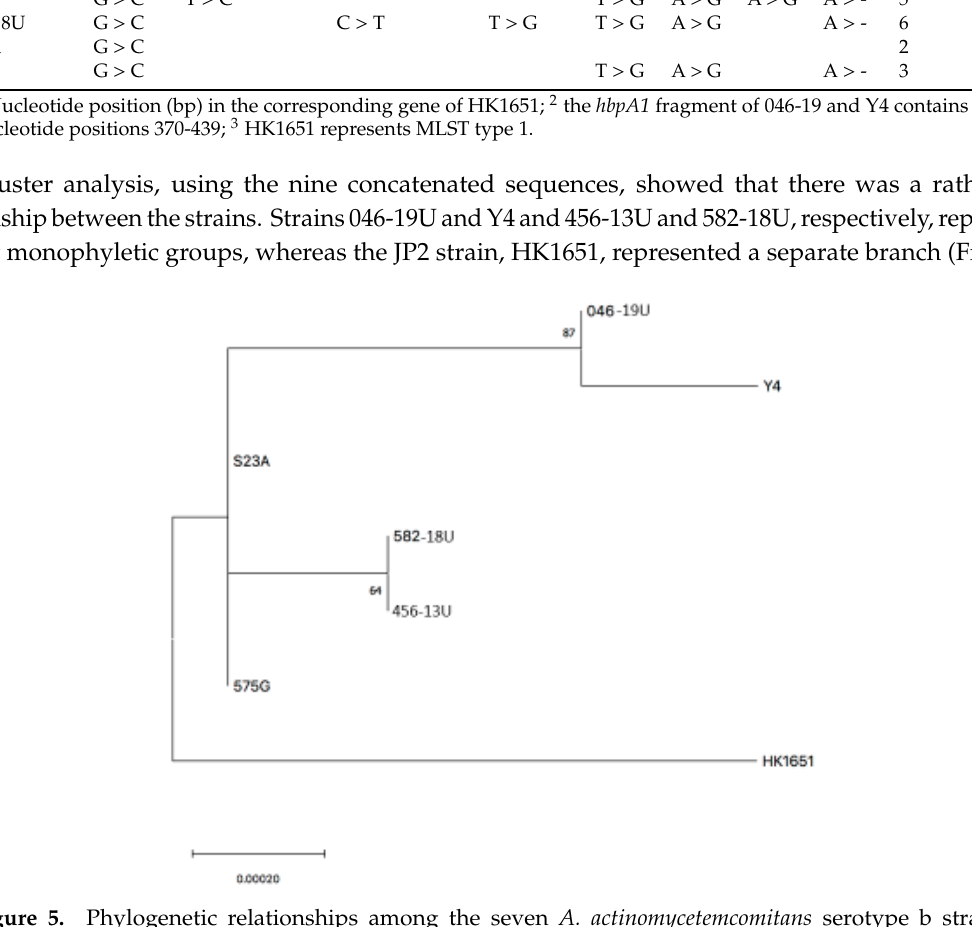
Figure 5. Phylogenetic relationships among the seven A. actinomycetemcomitans serotype b strains, representing five different ltxCABD promoter types, based on multilocus sequence typing (MLST) analysis, as described in Section 2. The tree with the highest log likelihood is shown. The percentages of trees in which the associated strains clustered together is shown next to the branches. The tree is drawn to scale, with branch lengths measured in the number of substitutions per site.